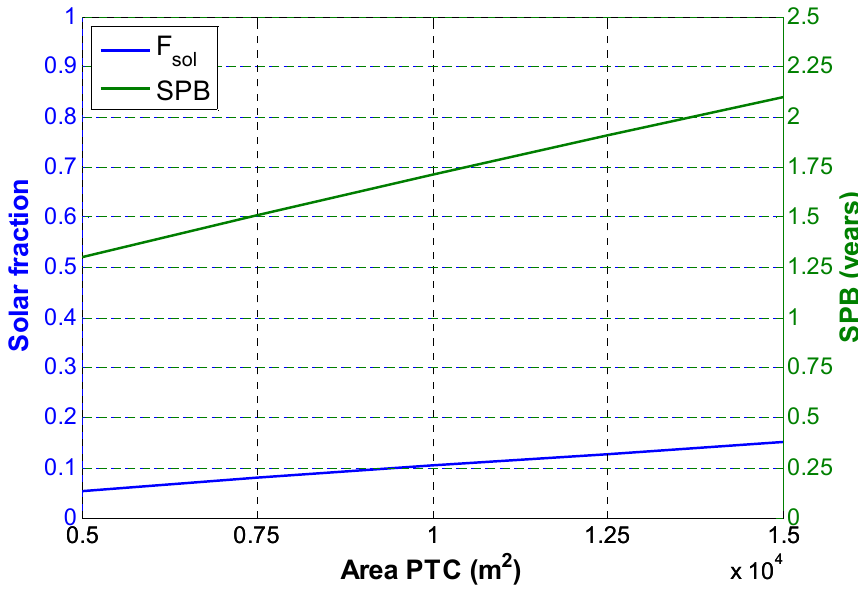
Figure 16. Solar fraction and SPB by varying the collector